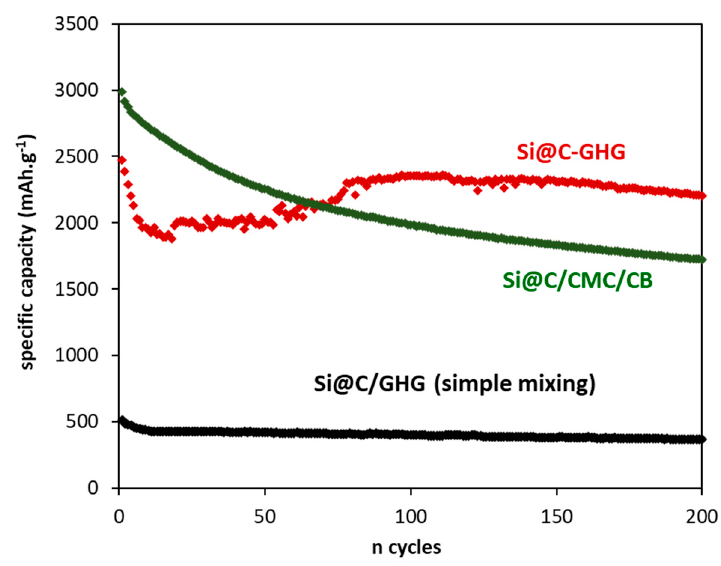
Figure 8. Cycling performances in half-cells of Si@C-GHG (red) after 18 h reaction at a charge/discharge rate of C/5 and comparison with the simple mixing of Si@C with GHG (black) and a standard formulation (green) consisting in a mixing of Si@C NPs, carbon black and CMC—50/25/25 %wt.